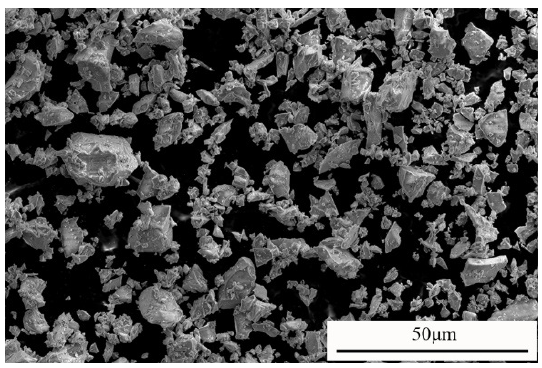
Figure 3. SEM image of GGBS.